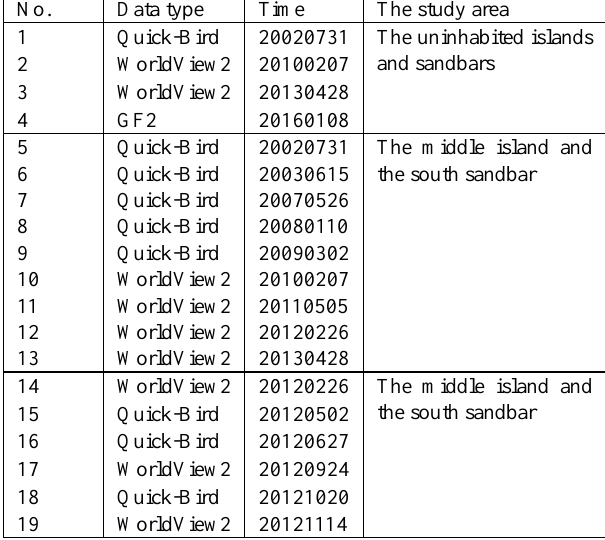
Table 1. Satellite data list